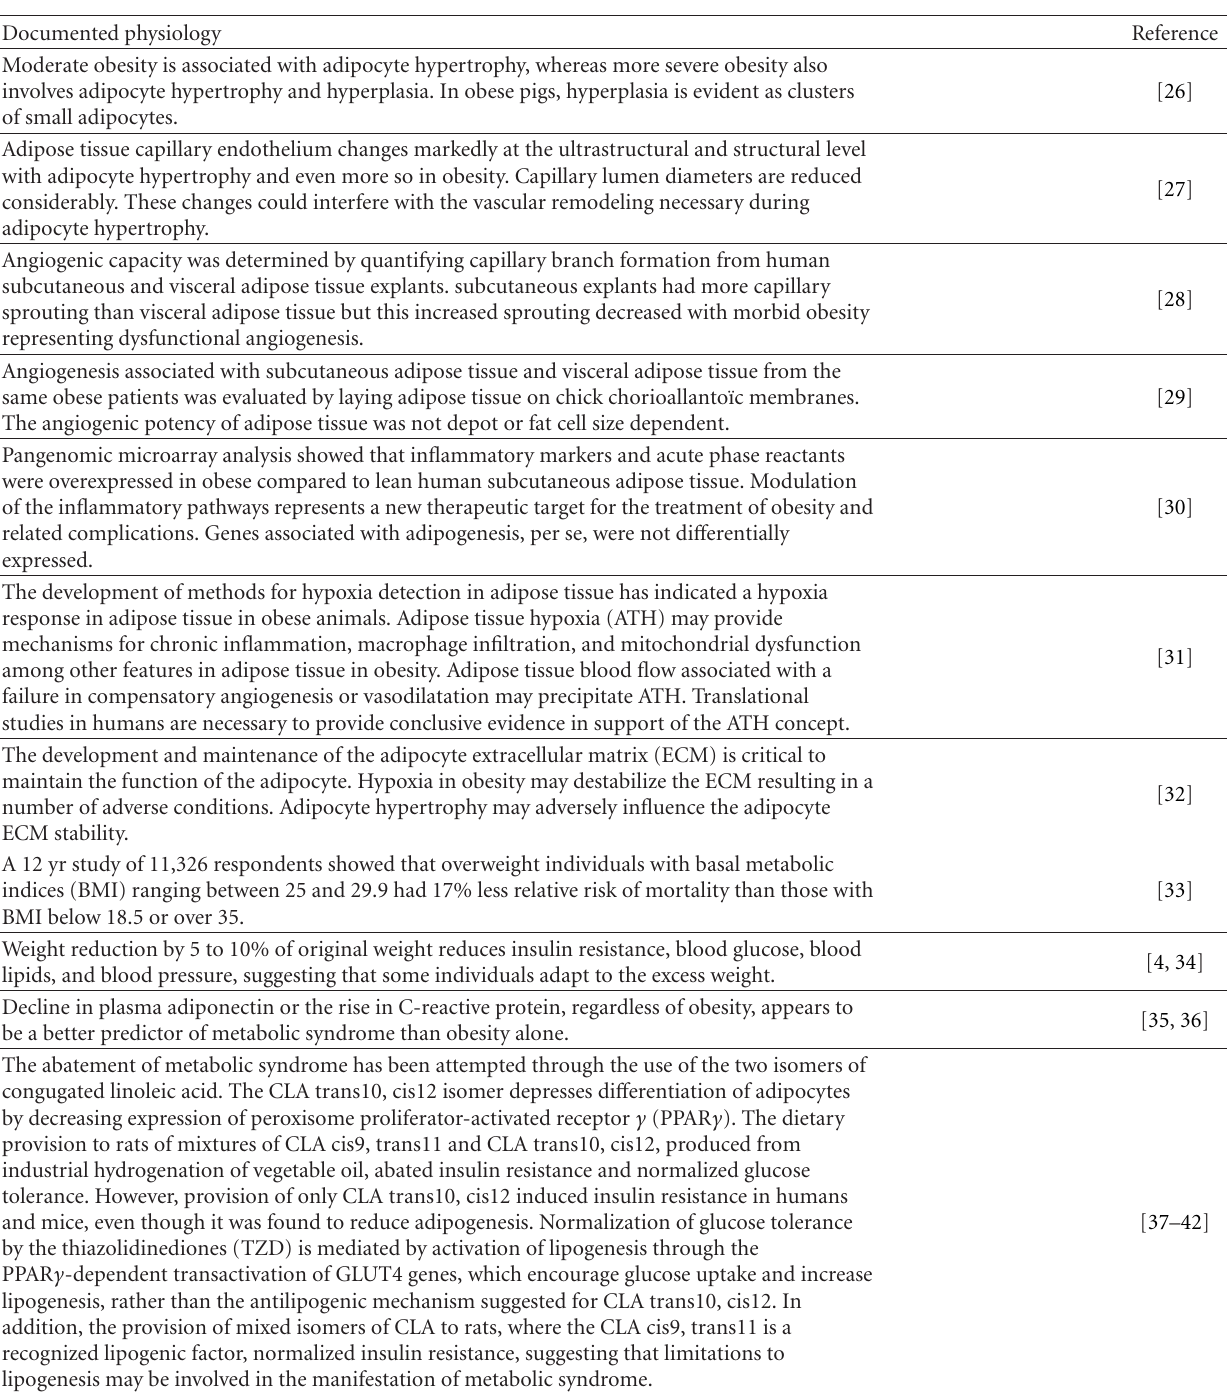
Table 1: Obesity, metabolic syndrome, adipogenesis, and